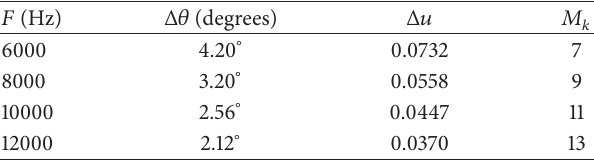
Table 1: Number of beams versus